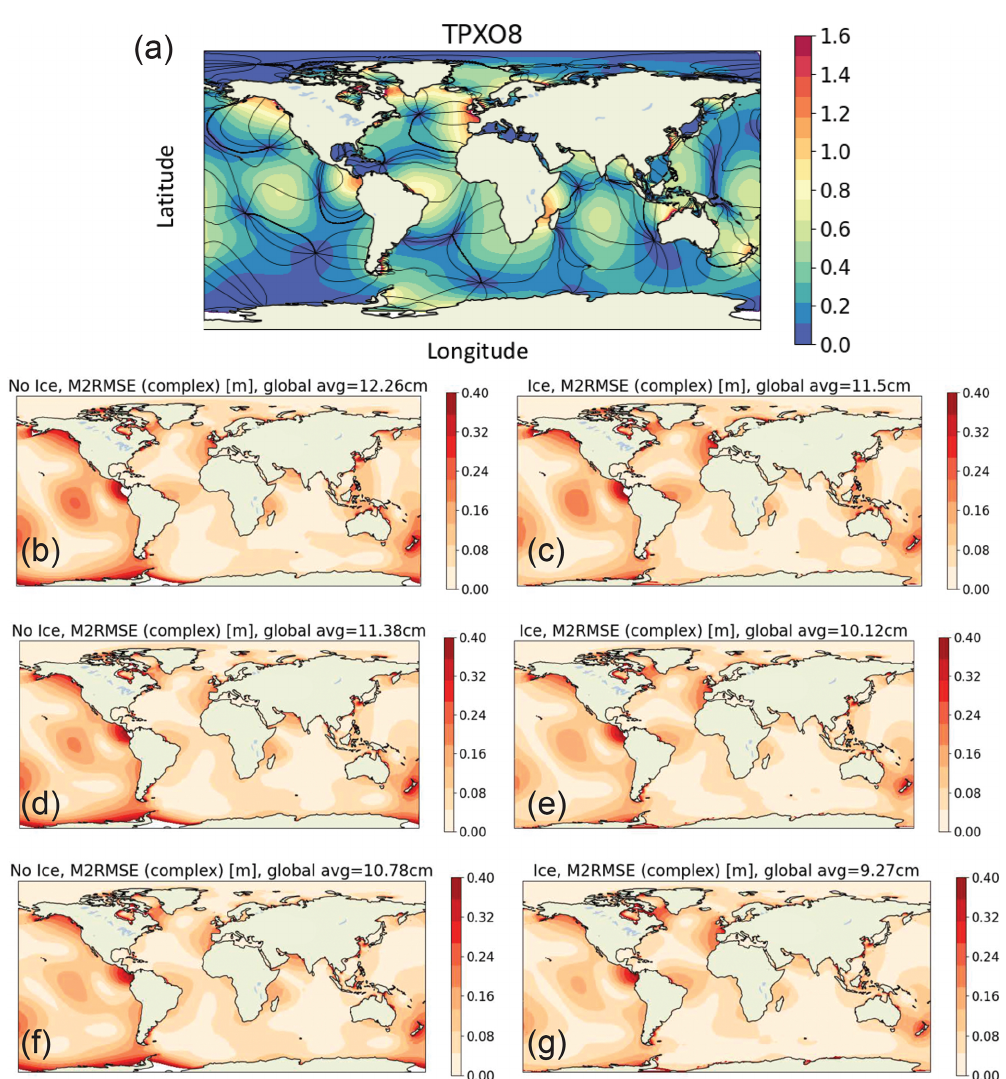
Figure 4. Icosahedral global tidal simulation results: (a) reference TPXO8 re-analysis mean M 2 amplitude (cm) with overlays of 90 ◦ phase contours. Complex RMSE (global, no depth or latitude restrictions) of M 2 constituent for (b) Icos8 n , (c) Icos8 is , (d) Icos9 n , (e) Icos9 is , (f) Icos10 n and (g) Icos10 is .